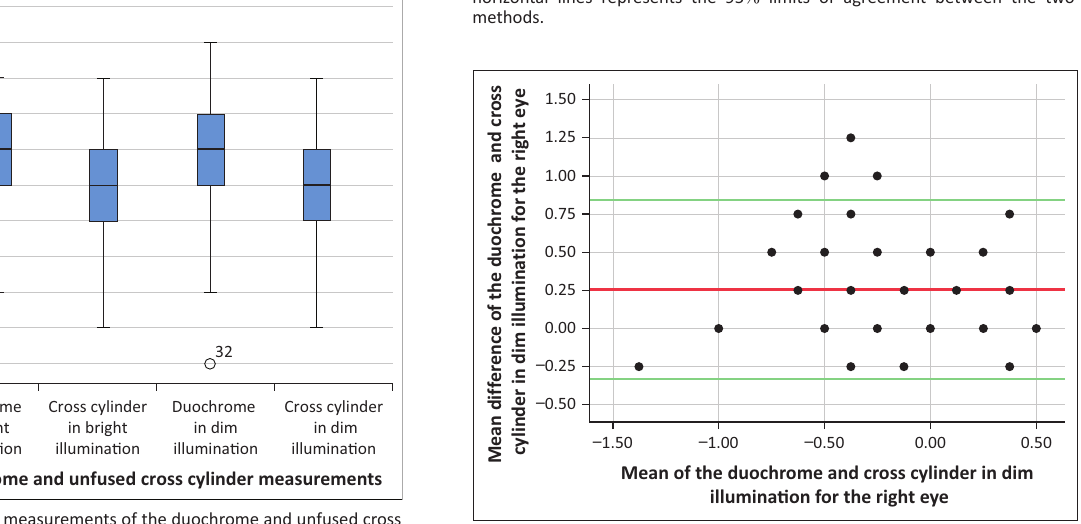
FIGURE 3: Plot of the means and differences between the duochrome and unfused cross cylinder tests in dim